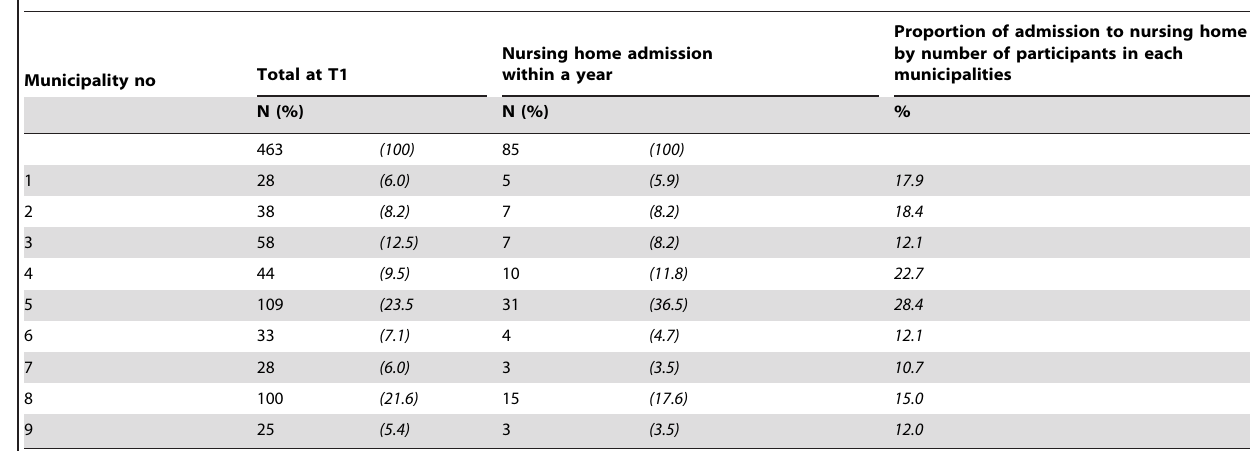
Table 2. Nursing home admission by the municipality of residence.